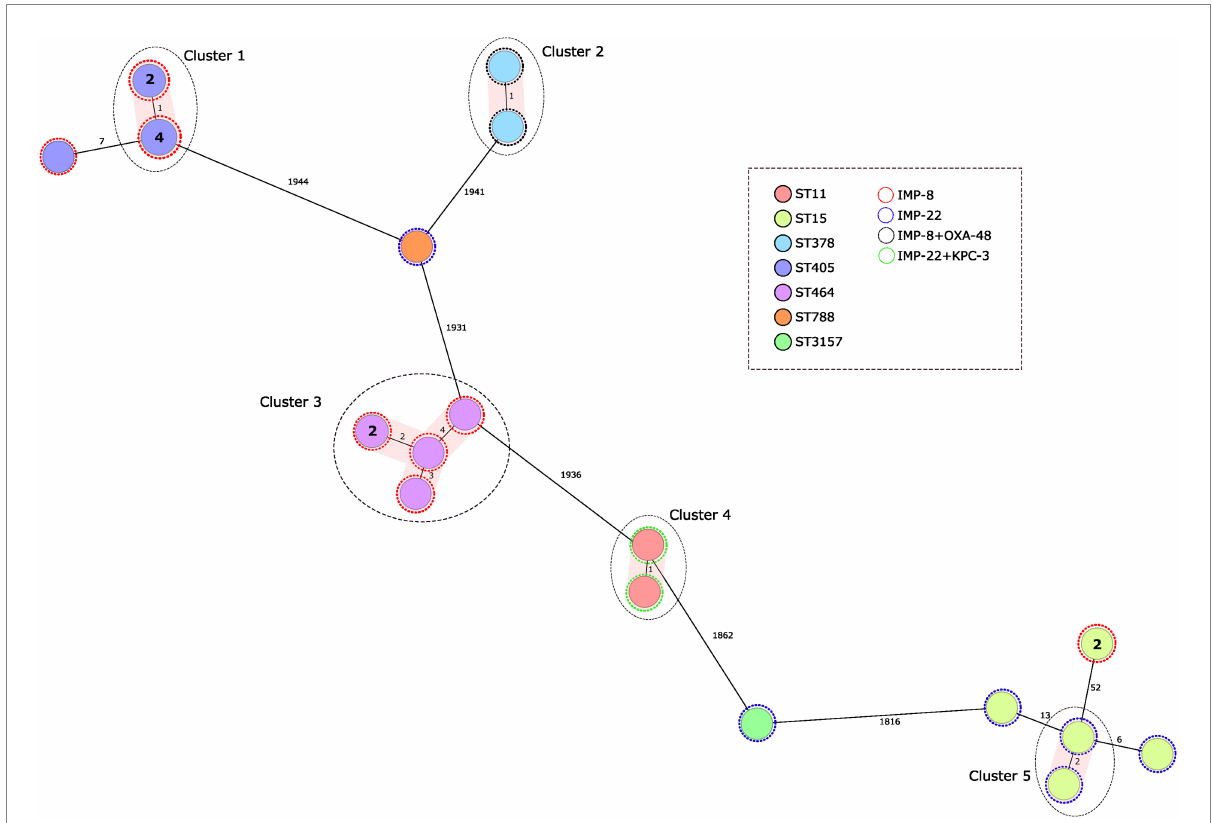
FIGURE 1 Population structure of IMP-producing Klebsiella pneumoniae : minimum-spanning tree. Distances shown are based on cgMLST of 2.358 genes using the parameter ‘pairwise ignoring missing values’. Fill colors in each circle indicate the MLST type and the color of the dashed line in circles indicates IMP type. Grey ovals represent clusters, applying a threshold of both 5 SNPs and 5